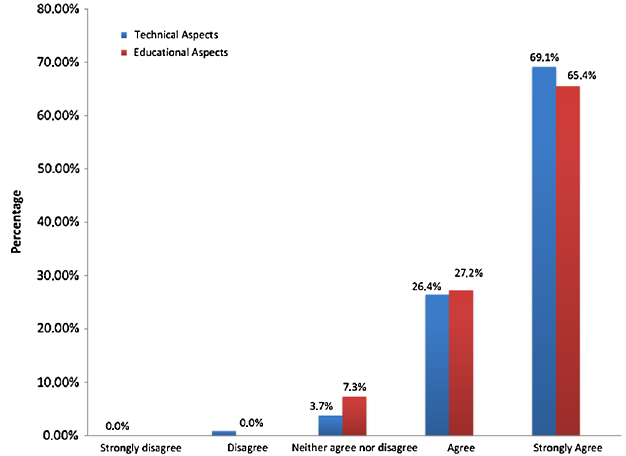
FIG. 10 (color online). Graphical representation of the stu- dents’